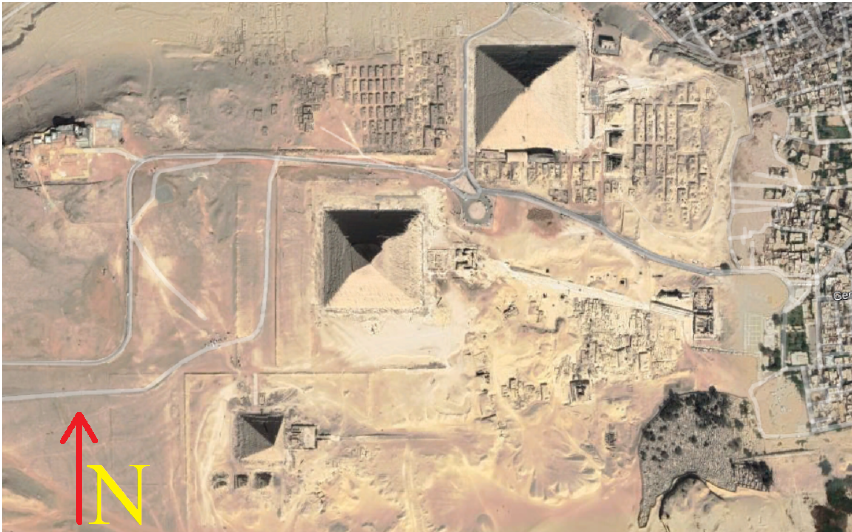
Figure 1. Optical satellite image of the Giza plateau. All pyramids are oriented to the North.